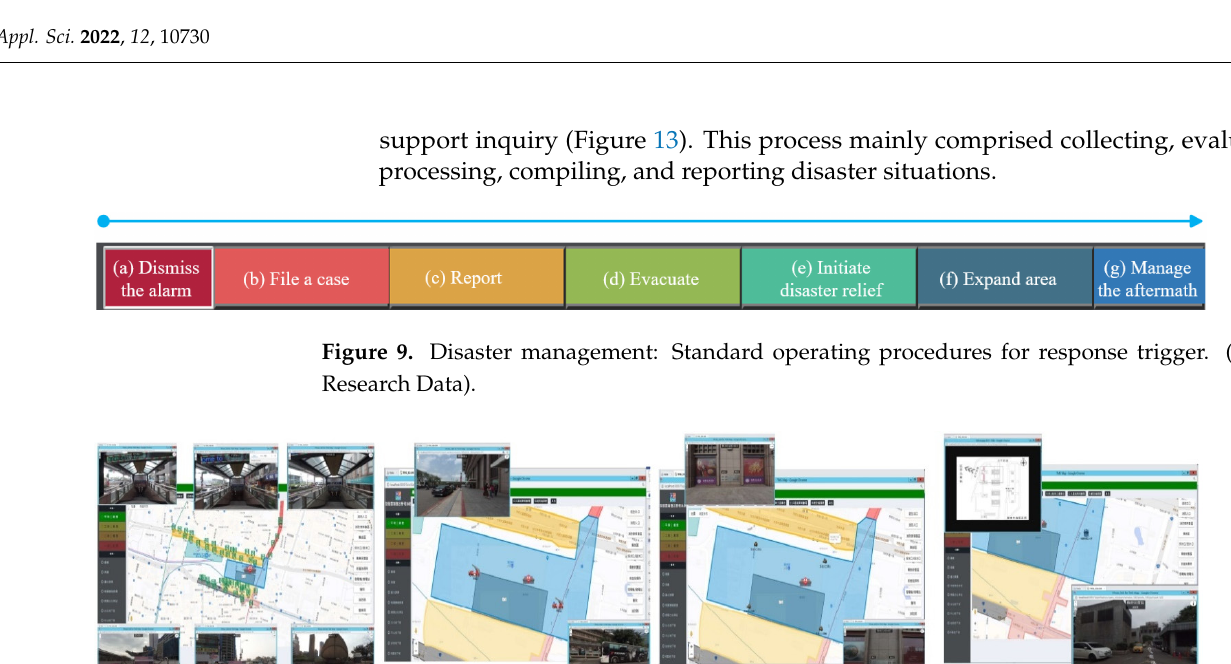
Figure 10. Disaster management: Graphical explanation of relevant geographical locations. (Source: Research Data). ( a ) Exit; ( b ) Fire truck parking areas; ( c ) Fire hydrant locations; ( d ) Casualty areas.